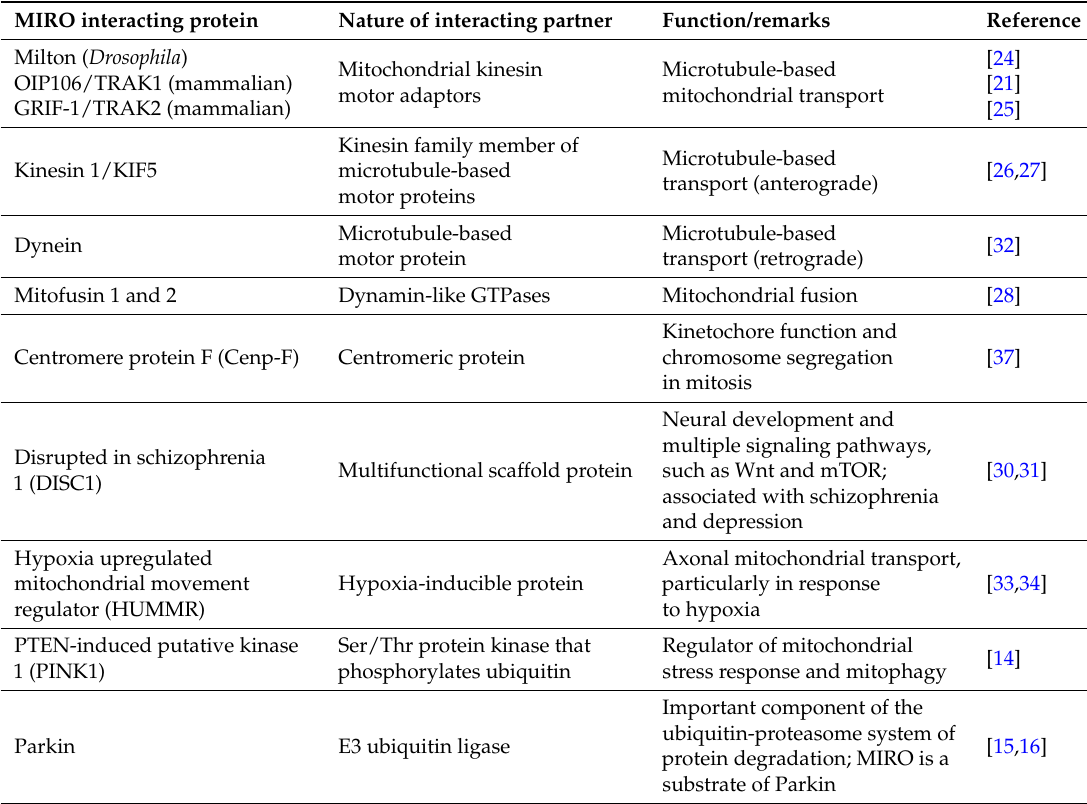
Table 1. A summary of known MIRO interacting partners and their